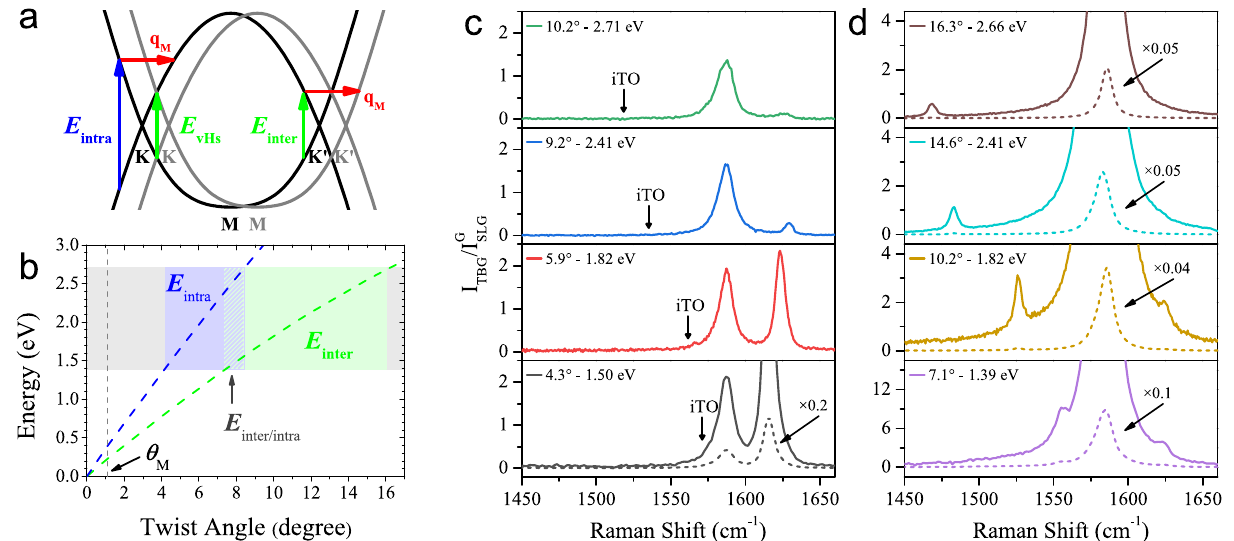
Figure 2. ( a ) Schematic diagram of the intralayer (blue arrow) and interlayer (green arrow) processes in the Dirac cones of two graphene layers. The grey (black) curves represent the electronic bands and the Dirac cones of layer A (layer B), and the red arrow represents the phonon wave vector, which corresponds to the unit vector q M of the Moiré reciprocal lattice. ( b ) Calculated dependence of the intralayer (dashed blue) and interlayer (dashed green) resonance energies, respectively, on the twisting angle 28 . The horizontal gray stripe denotes the range of excitation energies used in this work (1.39–2.71 eV) and the blue (green) rectangle highlights the range of angles of the TBGs activated by the intralayer (interlayer) el–ph process. ( c ) Raman spectra of samples with angles 4.3 ◦ , 5.9 ◦ , 9.2 ◦ and 10.2 ◦ recorded with the excitation energies of 1.50 eV, 1.82 eV, 2.41 eV and 2.71 eV, respectively. The excitation energy for each sample corresponds to the situation of maximum resonance for the Moiré peaks, as predicted for the intralayer resonance energy represented the blue dashed line in part ( b ). ( d ) Raman spectra of TBG samples with angles 7.1 ◦ , 10.2 ◦ , 14.6 ◦ and 16.3 ◦ recorded, respectively, with excitation energies 1.39 eV, 1.82 eV, 2.41 eV, and 2.66 eV. The excitation energy for each sample corresponds to the situation of maximum resonance for the Moiré peaks, as predicted for the interlayer resonance energy represented the green dashed line in part ( b ). The intensities of the TBG spectra were normalized by the intensity of the G band of single layer graphene